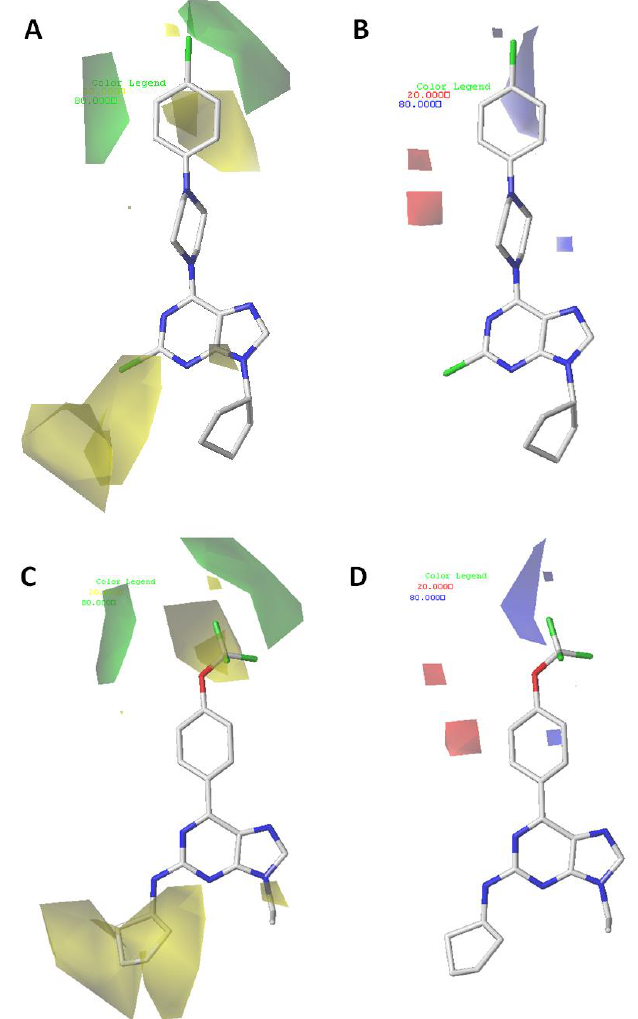
Figure 6. CoMFA HL-60: Steric ( A , C ) and electrostatic ( B , D ) contour maps around the most active compound of the series 7g ( A , B ) and the least active compound of the series 4a ( C , D ).